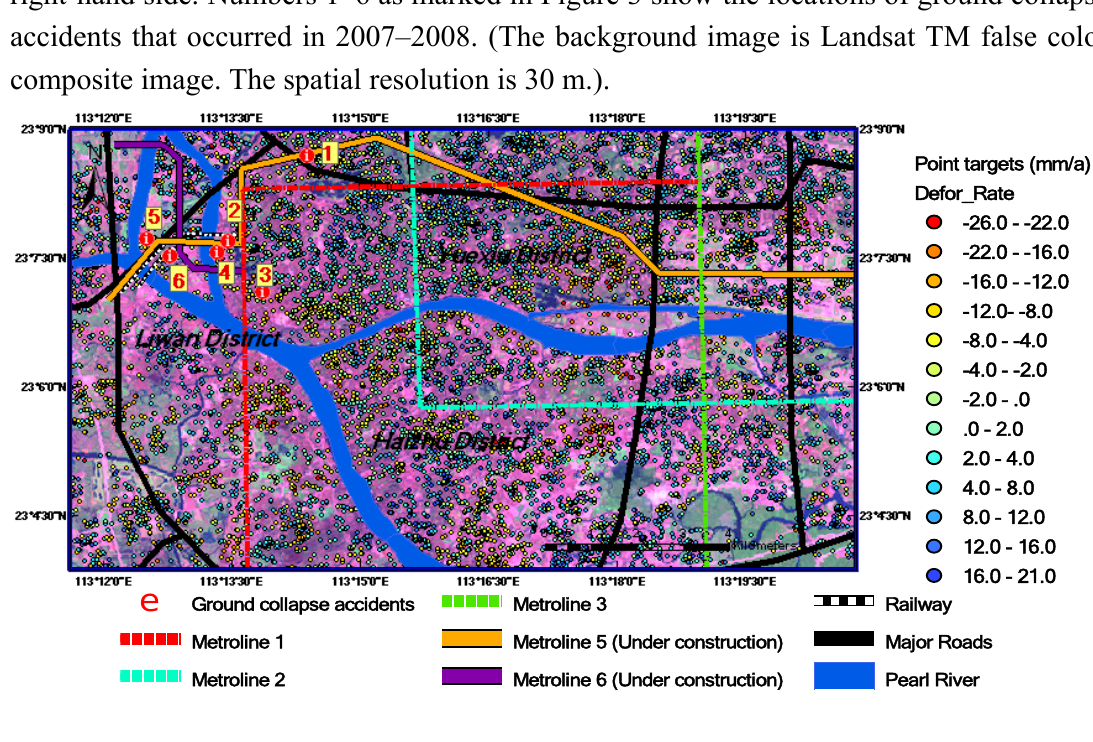
Figure 4. A ground deformation rate map of IPTA-derived point targets in